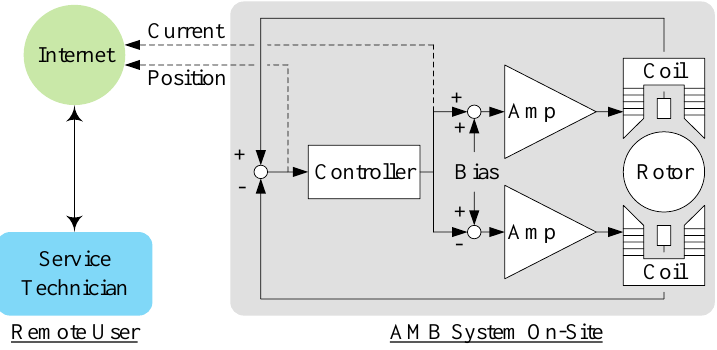
Figure 2. Condition monitoring of AMB system via the IoT concept.